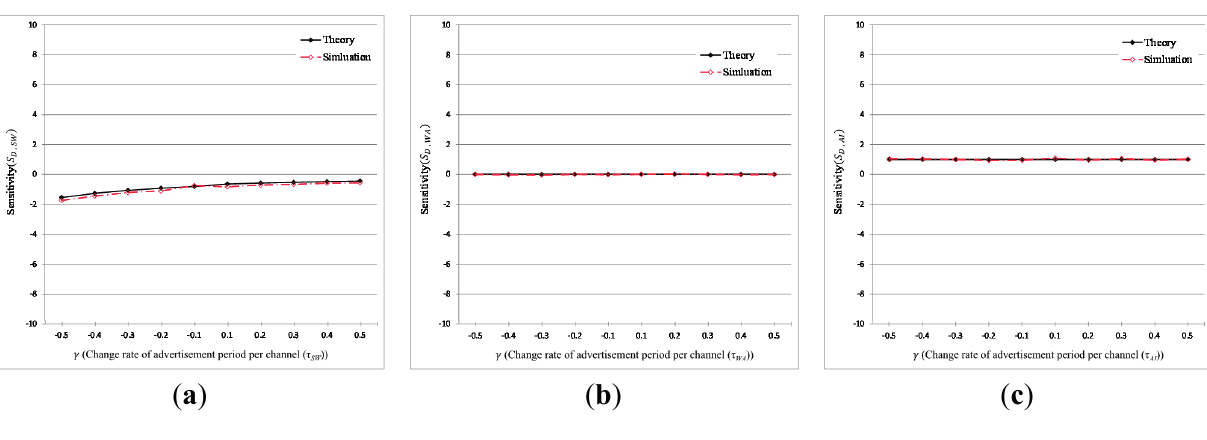
Figure 10. Sensitivity of mean discovery latency with various parameter setting. ( a ) The sensitivity of mean discovery latency to τ SW ( τ SI = 10,240, τ WA = 10, τ AI = 1280, M = 5, N = 5); ( b ) the sensitivity of mean discovery latency to τ WA ( τ SI = 10,240, τ SW = 2560, τ AI = 1280, M = 5, N = 5); ( c ) the sensitivity of mean discovery latency to τ AI ( τ SI = 10,240, τ SW = 2560, τ WA = 10, M = 5, N =